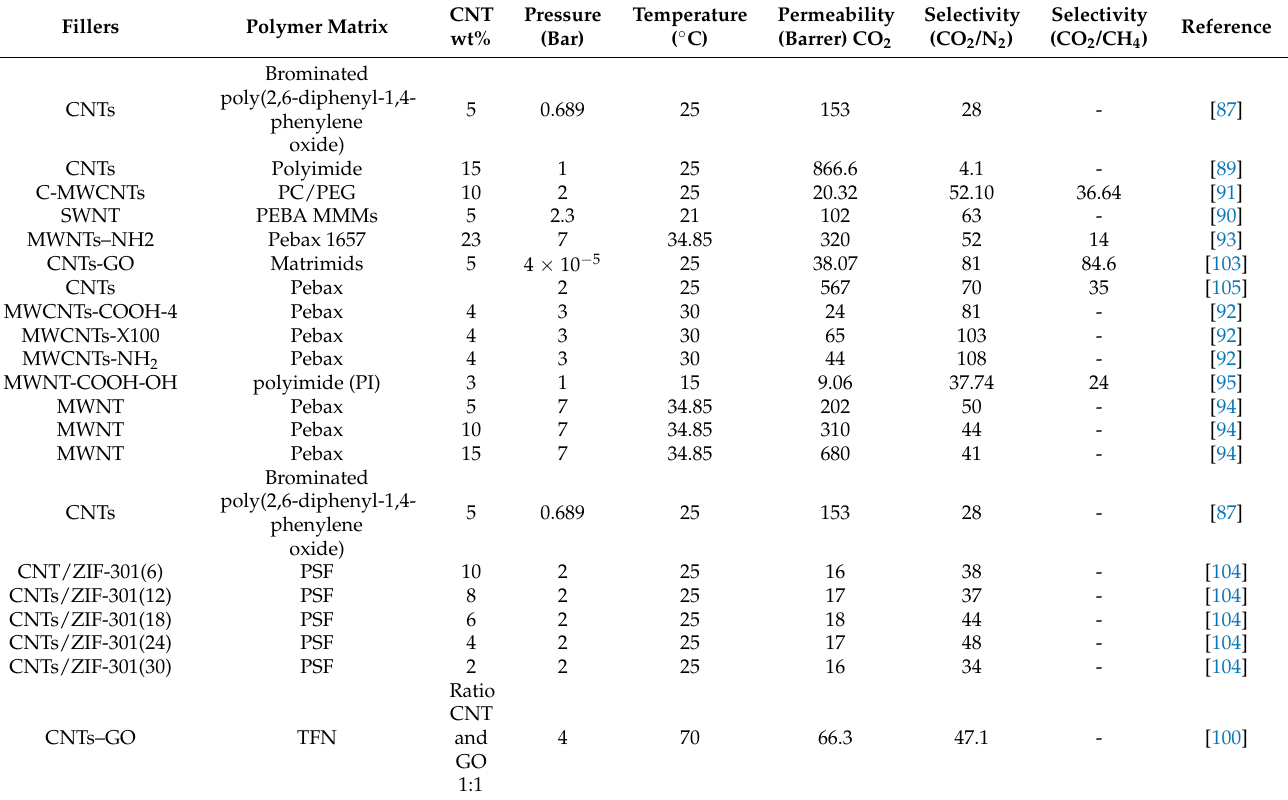
Table 1. Permeability and selectivity values of different CNT–MMM used in gas-separation processes.